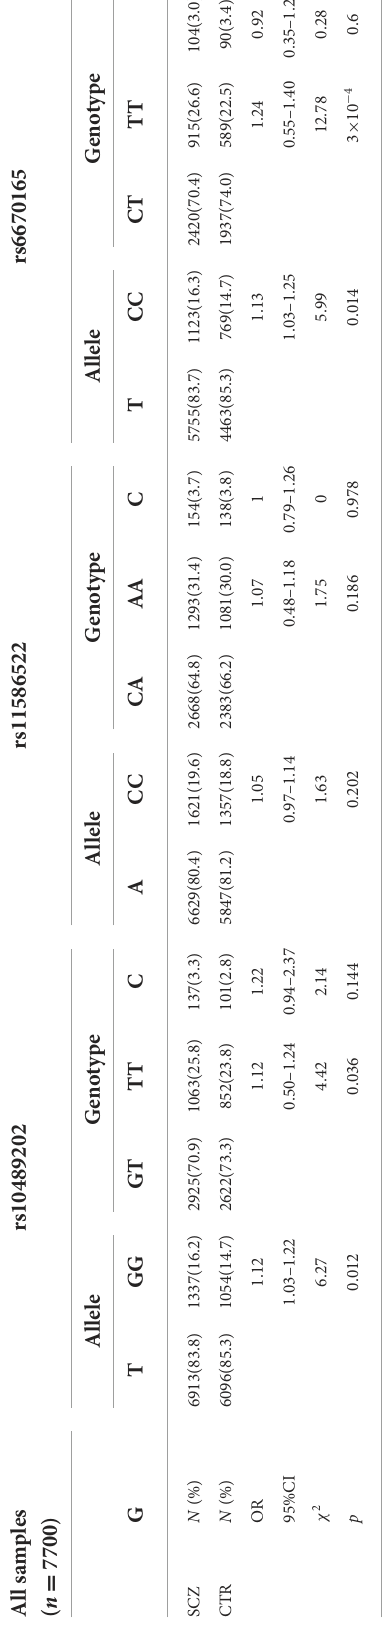
The rs532193193 is located in intron 6 of the SFT2D2 gene, a vesicle transporter of multipass membranes required for endosome-to-Golgi retrieval. The expression level of SFT2D2 mRNA increased in postmortem brain samples of patients with schizophrenia, including the pre-frontal cortex, hippocampus, and striatum (18 patients vs. 15 controls, Figure 1A). In single-cell analysis, there were higher SFT2D2 mRNA levels in peripheral immune cells than neuronal cells (Figure 1B), of which SFT2D2 was most abundant in pDCs that can rapidly and massively release type I interferon that may trigger autoimmune responses. Taken together, we hypothesized that overactive SFT2D2 in the brain and pDCs may disrupt self-surveillant homeostasis and trigger autoimmune inflammatory responses in schizophrenia.